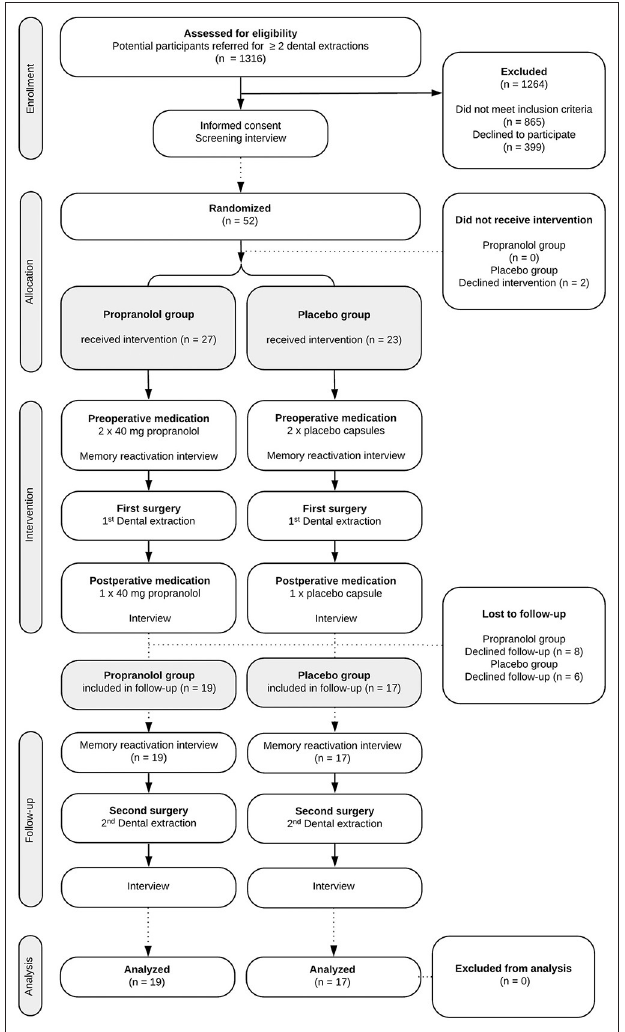
FIGURE 1 | Flow-diagram of study